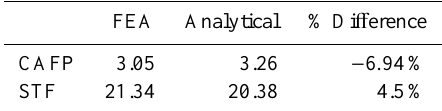
Table 3. Comparison of FEA and analytical predictions of sti ff ness for CAFP and STF. All sti ff nesses are in Nmrad − 1 .